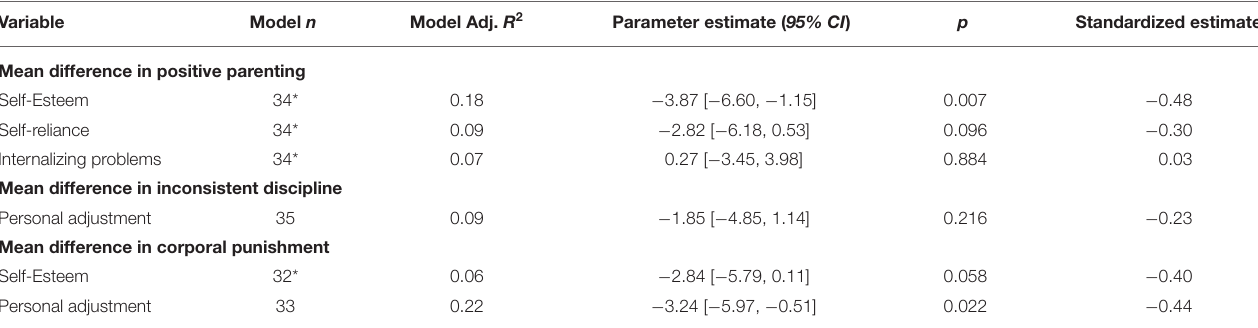
TABLE 4 | Multivariable linear regression models examining relationship between mean positive parenting difference score and child mental health